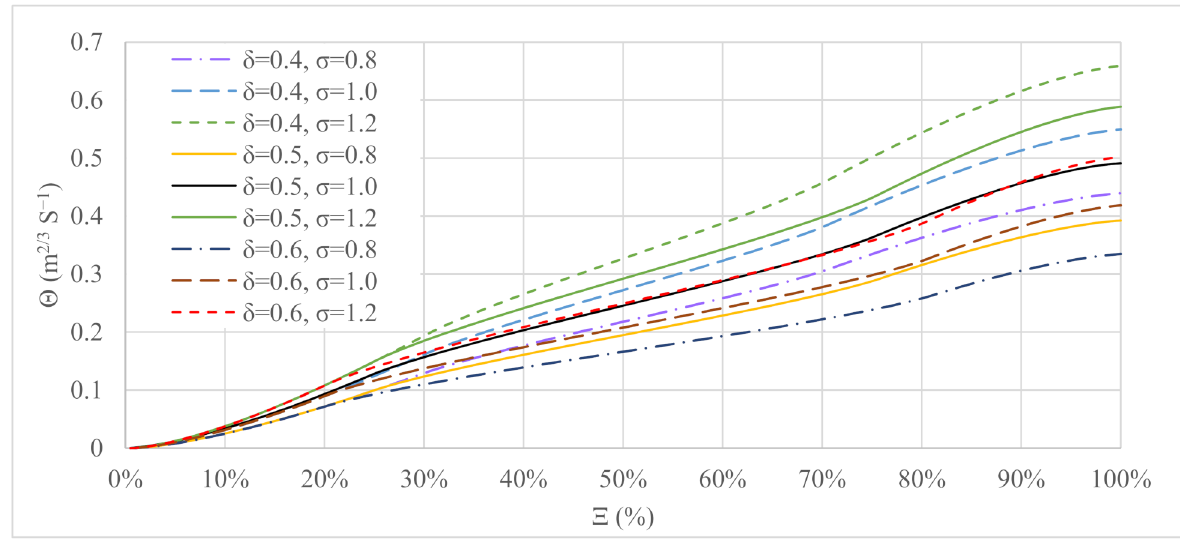
Figure 8. The corresponding Θ of different δ and σ for a full range of Ξ